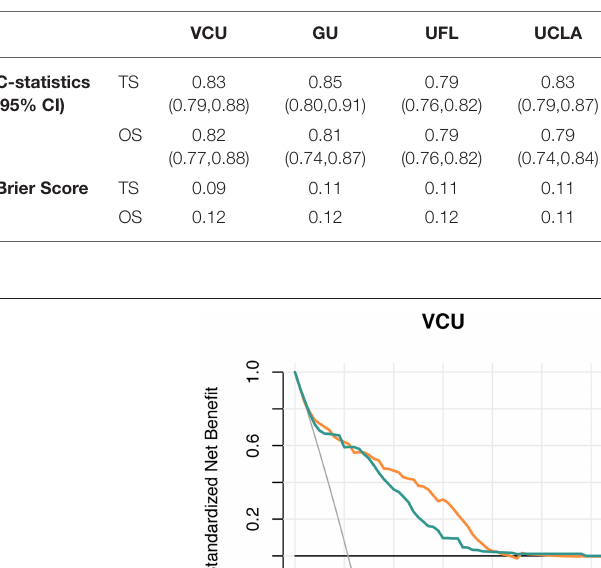
Frontiers in Medicine |